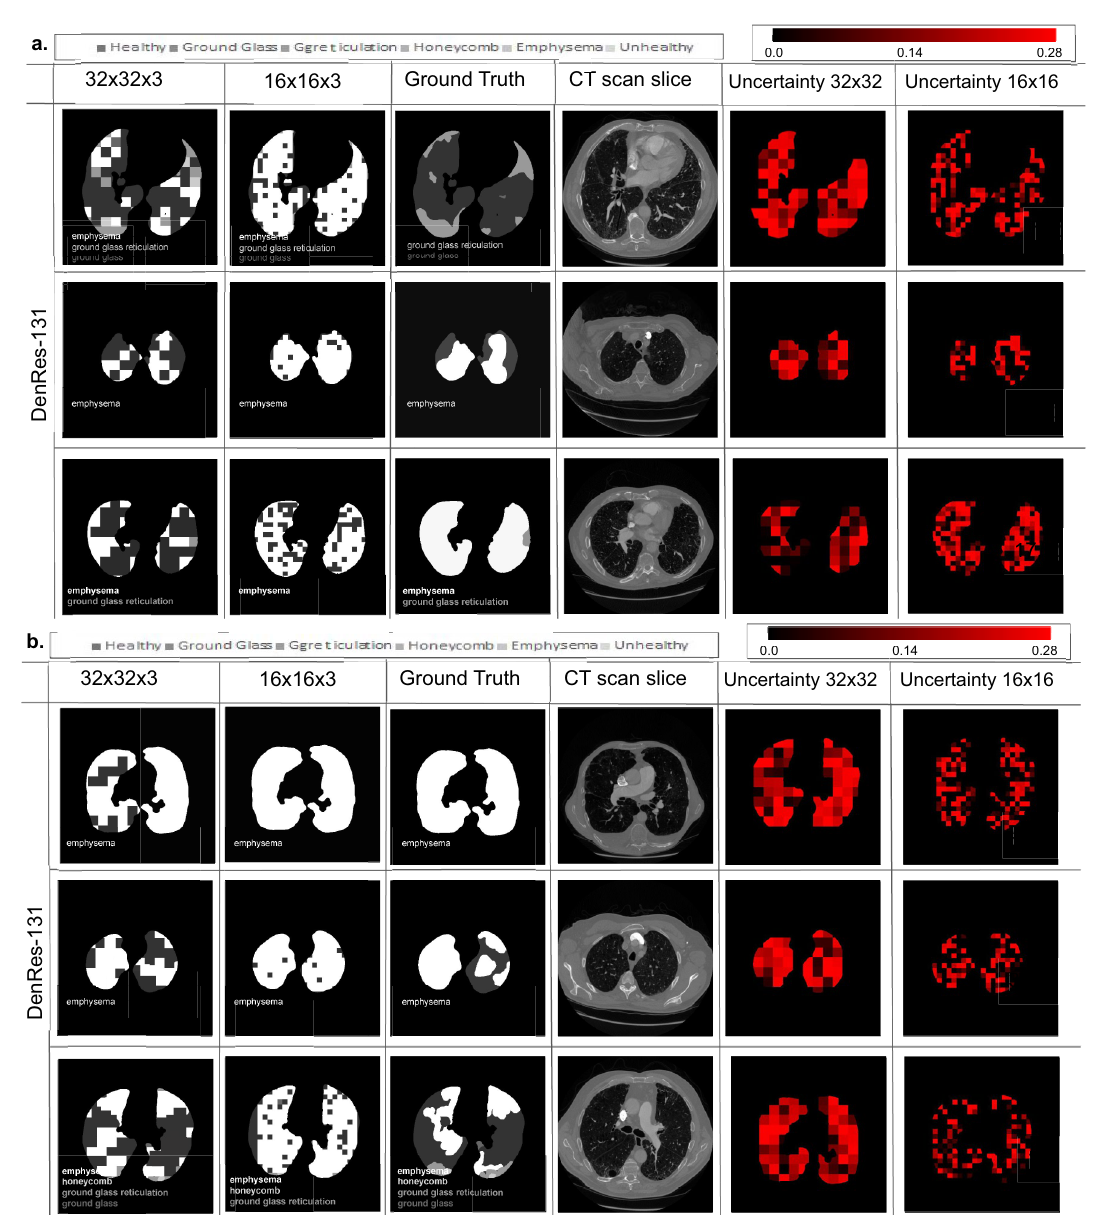
Figure 3. The multi-classification results of six different patients of the ‘unseen’ cohort (PART 1). ( a , b ) From left to right the prediction results of the patch sizes ( 32 × 32 × 3 , and 16 × 16 × 3 ), the radiologist ground truth, the patient CT slice of short axis, the uncertainty mapping of 32 × 32 × 3 , and the uncertainty mapping of 16 × 16 × 3 . The six different classes are showing in gray-scale colours. The uncertainty scale is with red-scale from 0.00 to 0.30